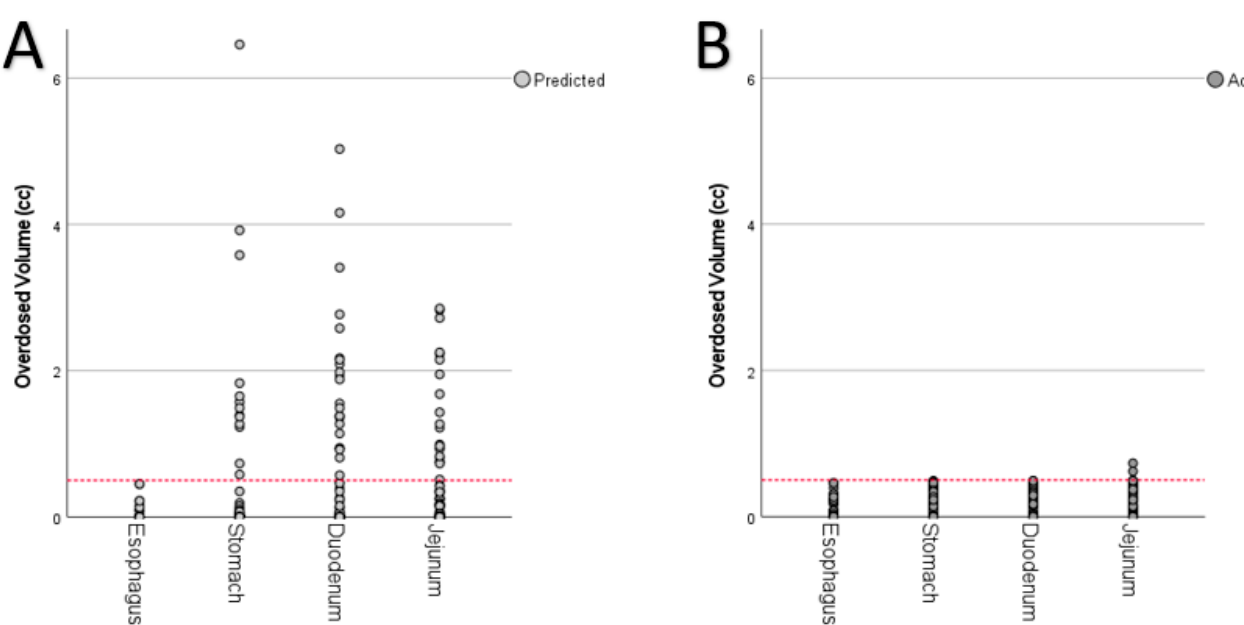
Figure 5. Overdosed volume (cc) of organs at risk for predicted plans ( A ) and adapted plans ( B ). The dashed line represents the aimed threshold of 0.5 cc.